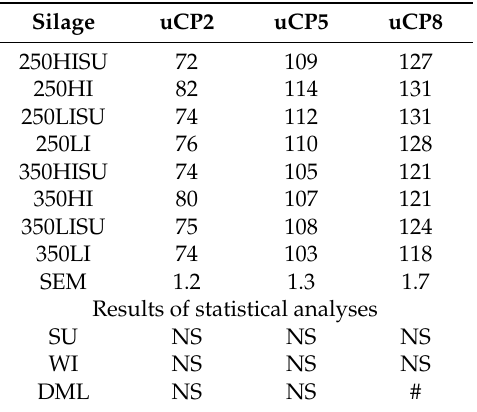
Table 5. Effect of sucrose addition (SU), wilting intensity (WI), and dry matter (DM) level (DML) on effective utilizable crude protein at the duodenum (g kg − 1 DM). Silage uCP2 uCP5 uCP8